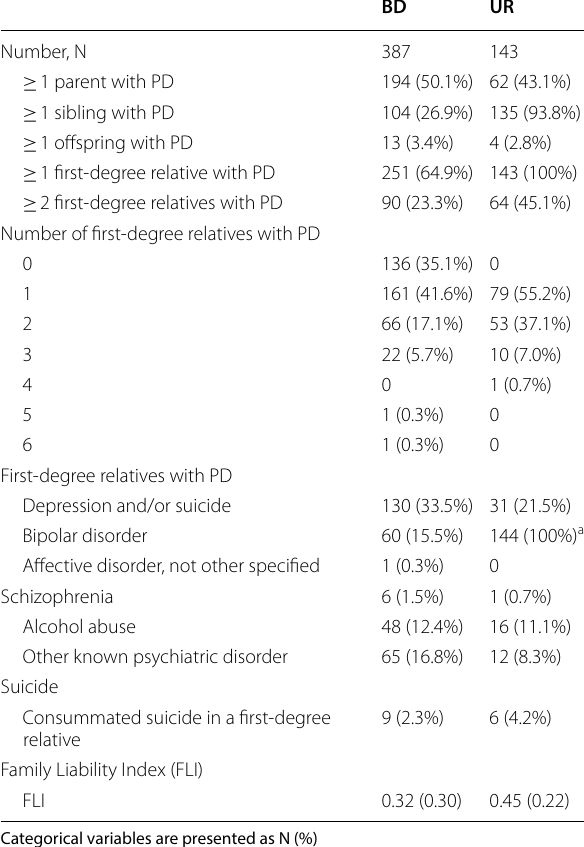
Table 2 Familial load (FL) of psychiatric disorders (PD) in patients newly diagnosed with bipolar disorder (BD) and their unaffected first-degree relatives